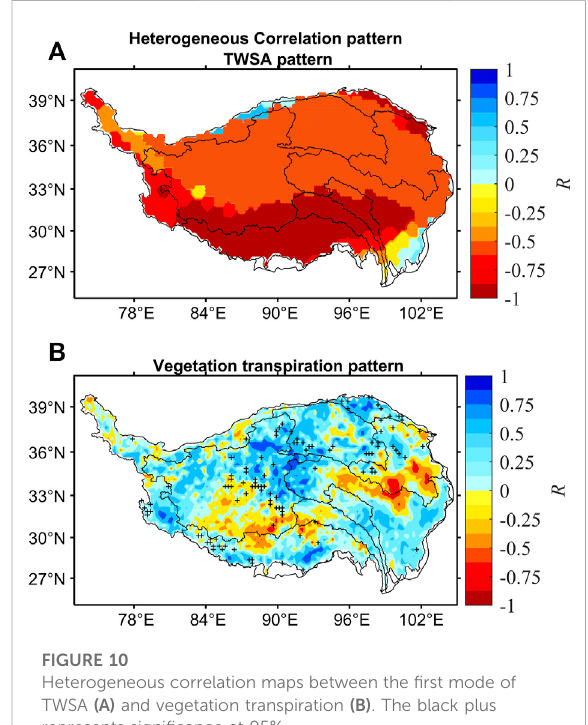
FIGURE 10 Heterogeneous correlation maps between the fi rst mode of TWSA (A) and vegetation transpiration (B) . The black plus represents signi fi cance at